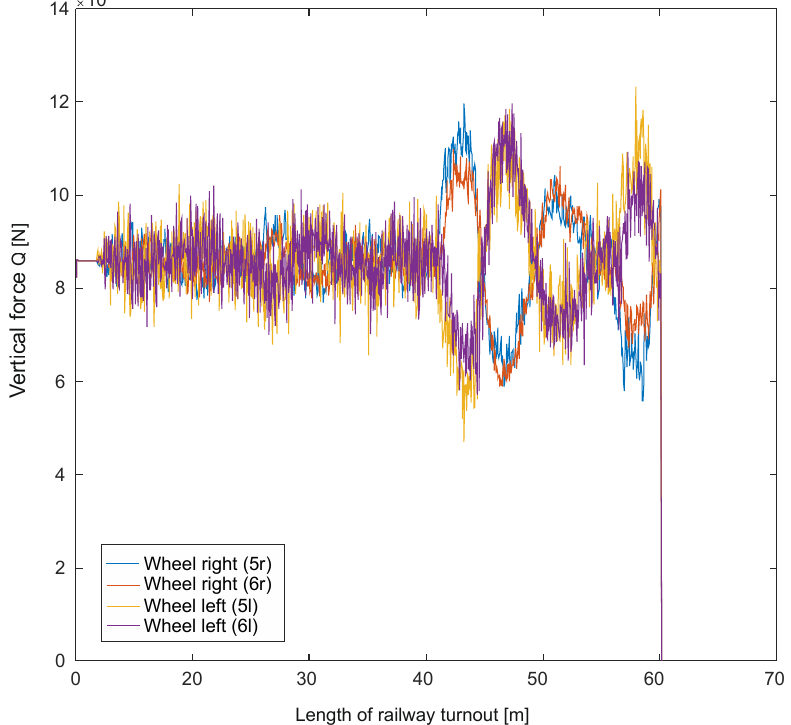
Figure 10. Vertical force at 300 km/h on a straight track through a turnout.